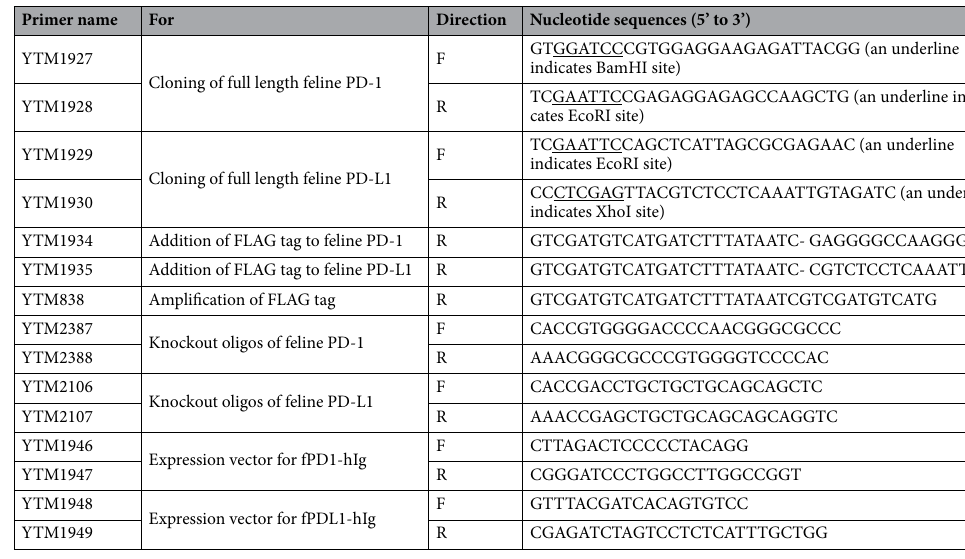
Table 2. The primers used for cloning and construction of plasmid vectors. F forward, R